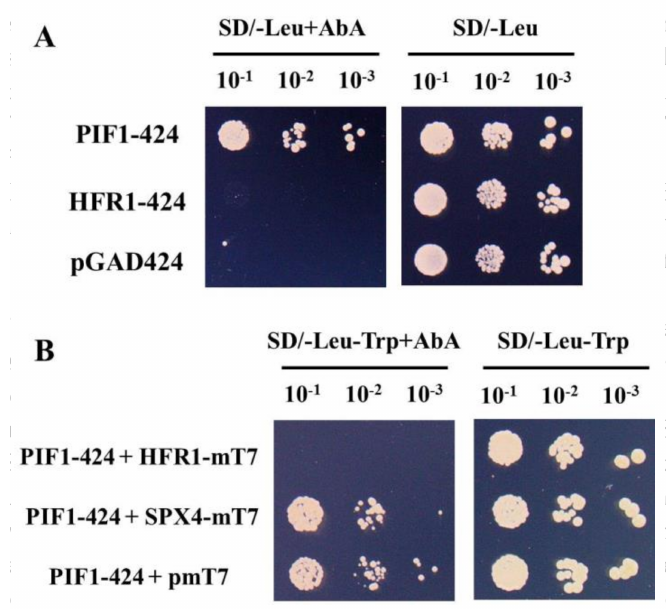
Figure 2. HFR1–PIF1 interaction inhibited PIF1 binding G-box element in yeast. ( A ) Y1H analysis of the binding of PIF1 to G-box element. The PIF1 and HFR1 were cloned into pGAD424 (named PIF1-424